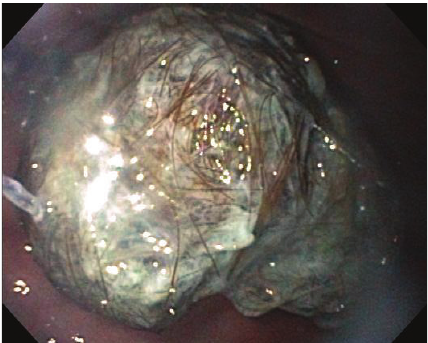
Figure 2: Trichobezoar visualized on